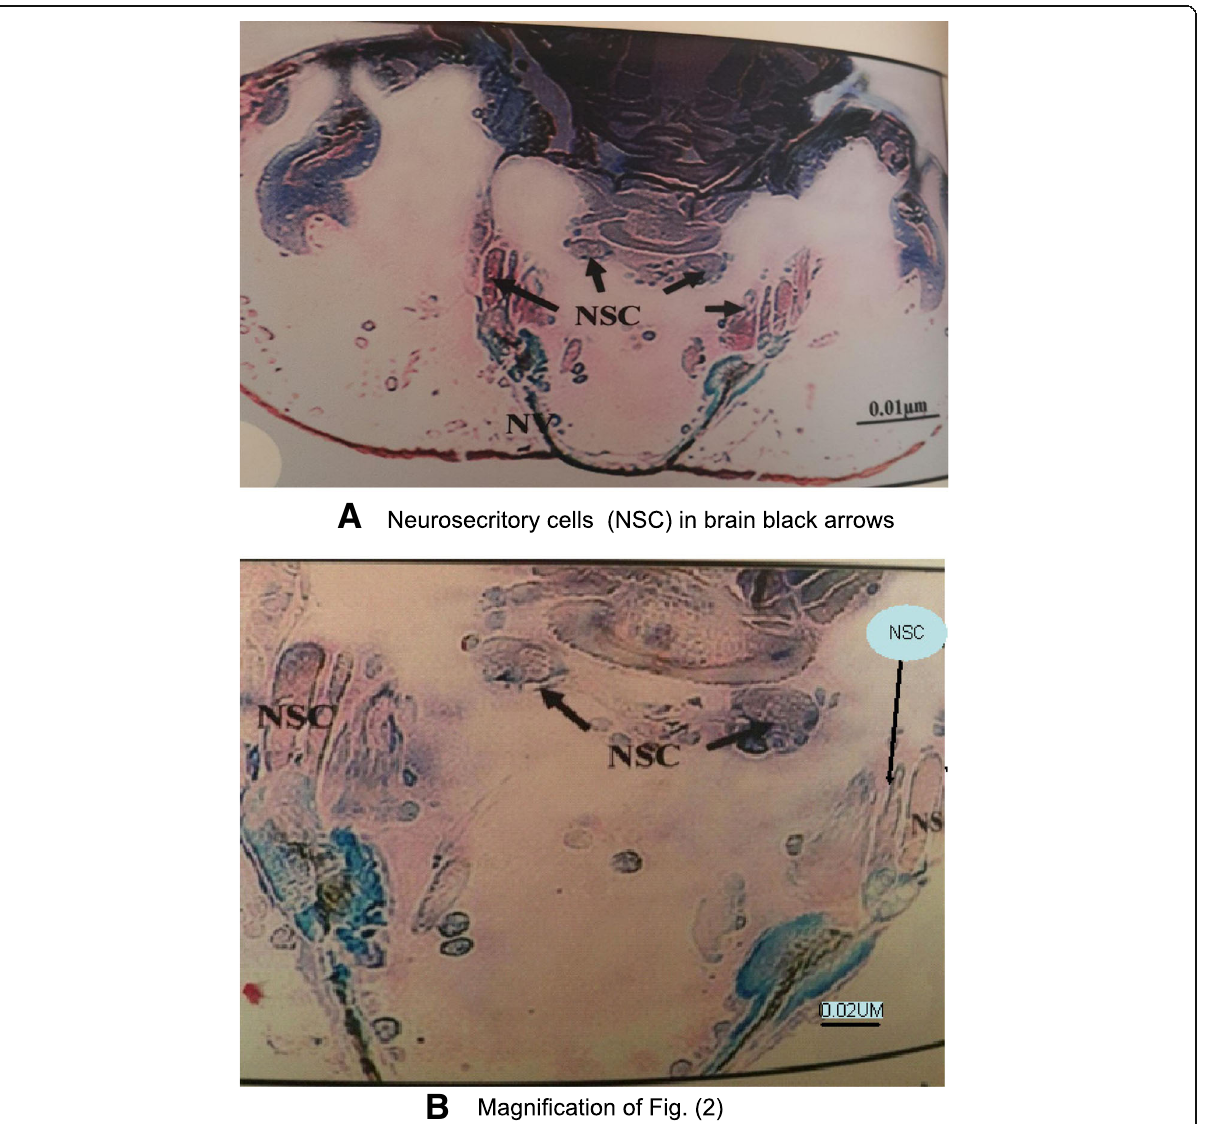
Fig. 2 Neurosecretory cells (NSC) in the brain, black arrows. Semi-thin sections by a light microscope in different parts in the endocrine organs in larvae of the potato tuber moth Phthorimeae operculella ( a normal and b treated larvae). Abbreviations: NSC neurosecretory cells in medial cerebral, NV nerve, CC corpora cardiac, NC nerve cells, NL neural lamella, D dendrites, HS droplets of secretion, SG salivary gland, HSD hormone secretion droplets, NM neuropile mass, CA corpus allatum, AO aorta, Tr tracheoles, Pg prothoracic gland, C cell body, M membrane, BM basal